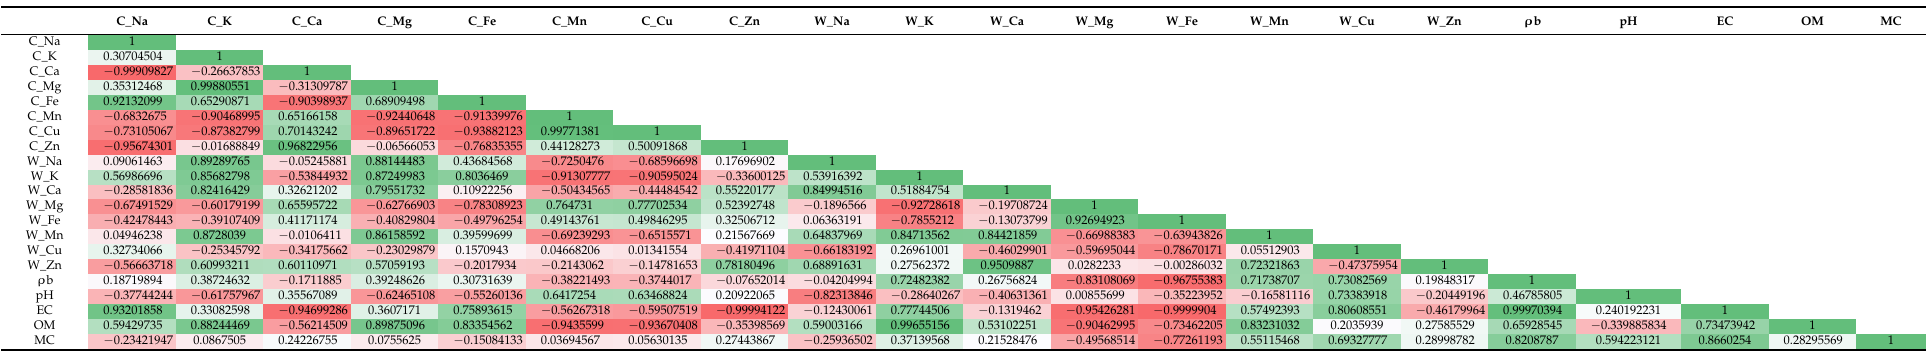
Table A6. Correlation coefficients between elemental composition nutrient content, water extractable nutrient content and physical and chemical properties of